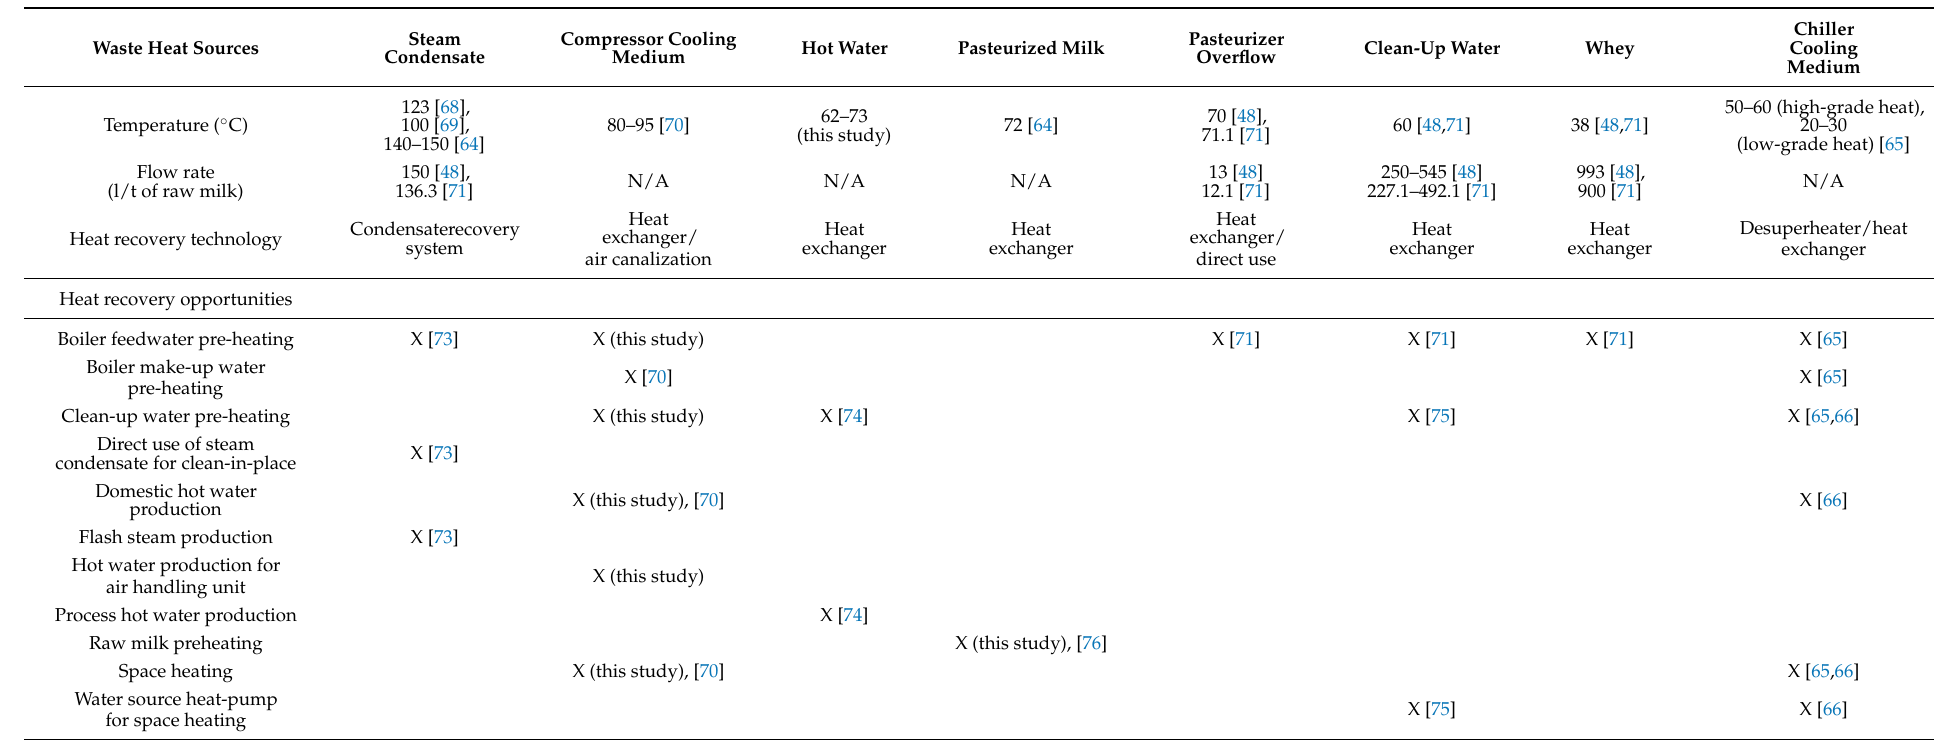
Table A8. Scheme providing the characterization of waste heat sources from hard cheese production and the identification of possible heat